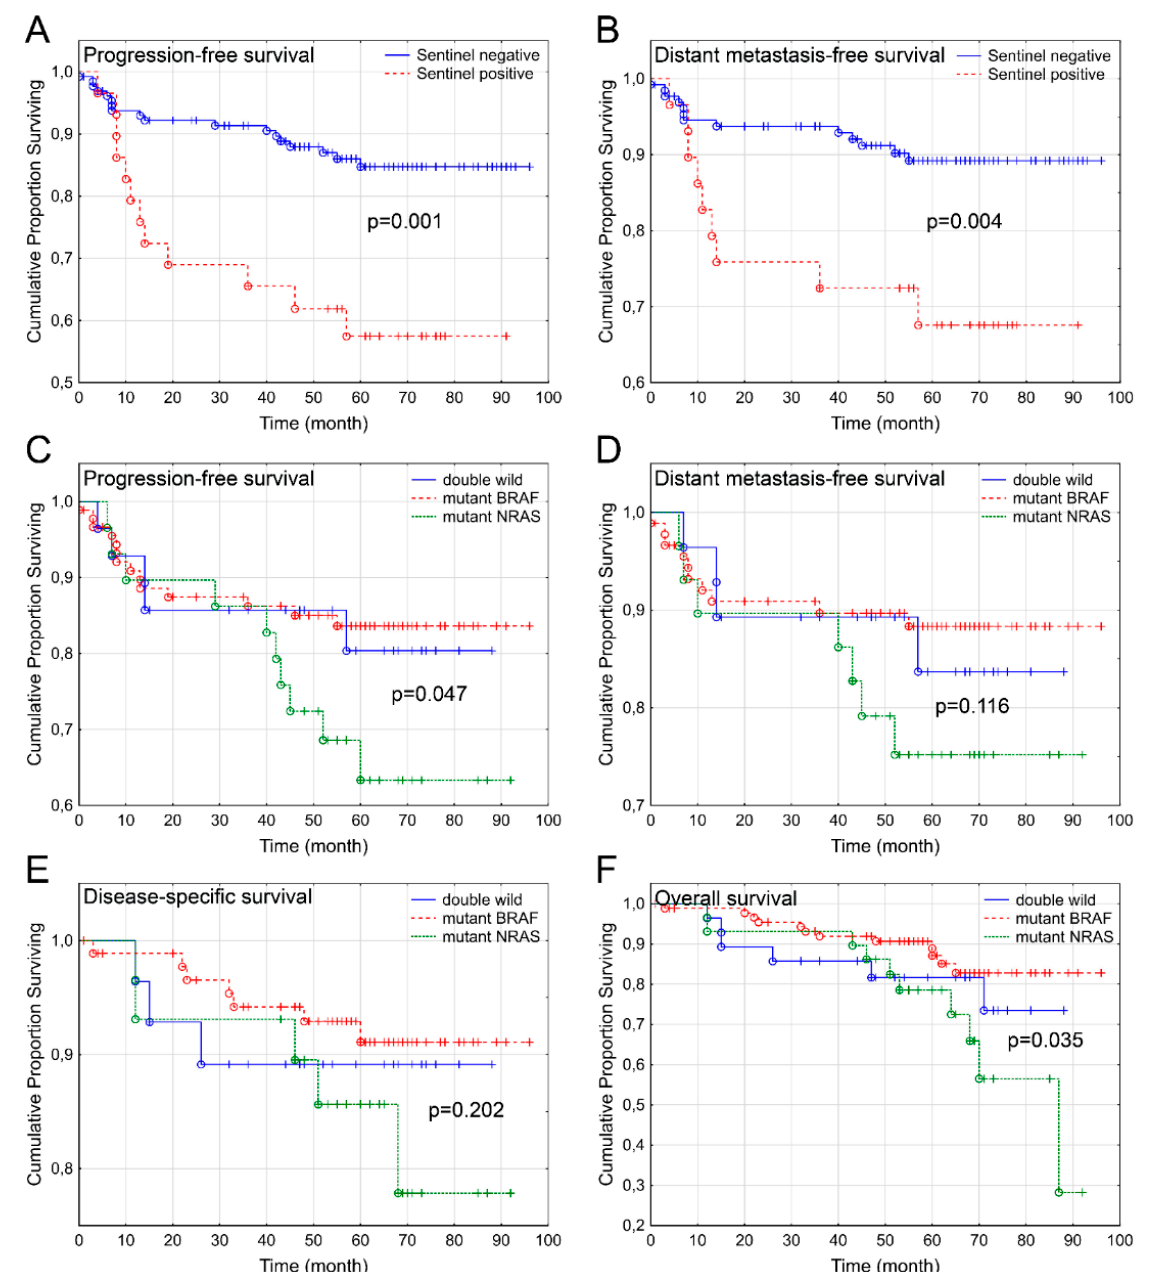
Figure 1. Kaplan–Meier curves of melanoma patients according to sentinel lymph node positivity and molecular subtypes. Sentinel lymph node positivity significantly impaired progression-free ( A ) and distant metastasis-free survival ( B ). Mutational status was analyzed in the primary tumor. Since the BRAF-mutant and double-wild-type subgroups showed a similar pattern, these categories were merged during the statistical analysis. Comparing the wild-type and NRAS-mutant groups, the latter showed a less favorable progression-free survival ( C ), while distant metastasis-free ( D ) and disease-specific ( E ) survival were not different. The overall survival ( F ) of NRAS-mutant patients showed a significantly worse outcome compared to that of the wild-type-NRAS subgroup. (o: Complete event; +: censored